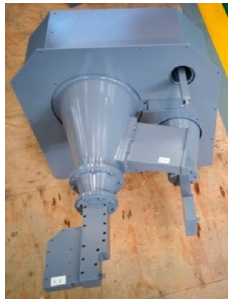
Figure 7. Outer view of the multi-band antenna.